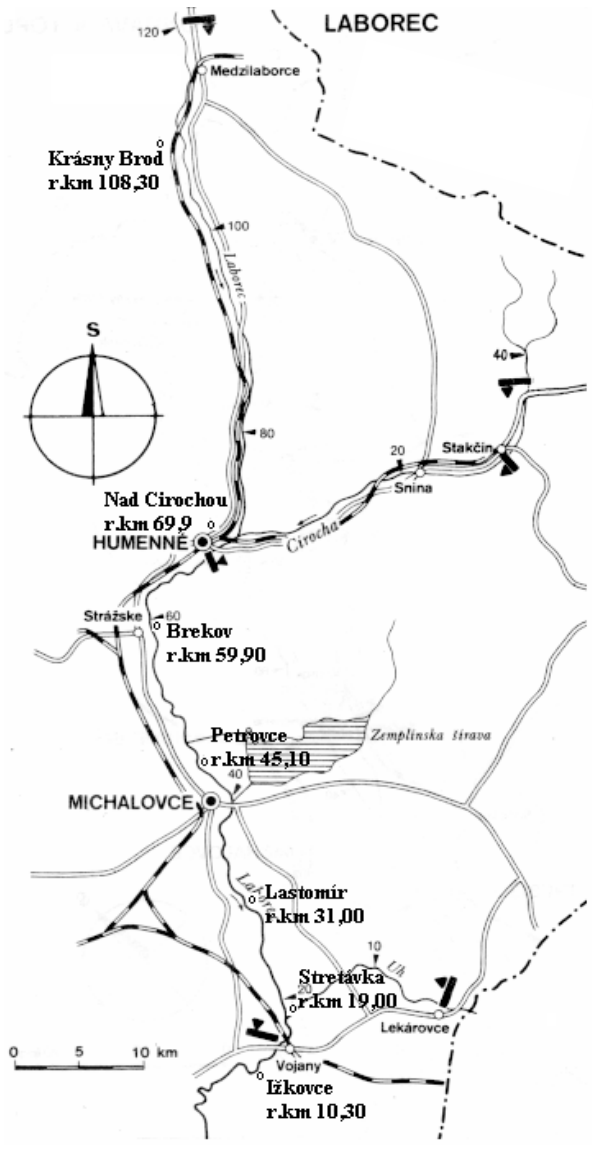
Fig. 1. River Laborec – eastern Slovakia with indication of the Iˇzkovce river station. Figure 1. River Laborec – eastern Slovakia with indication of the Ižkovce river station. 20